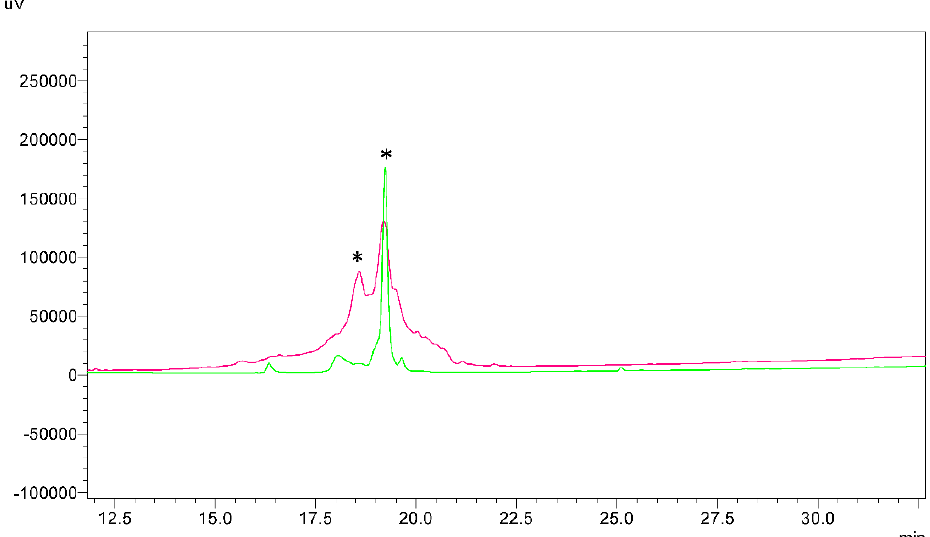
Figure 7. Chromatograms of the folded HBD-3. A green trace denotes the native-like form of HBD-3 #1 synthesized using the orthogonal Cys protection strategy. A pink trace indicates products of the directly folded HBD-3 carried in the presence of 1 mM GSSH and 1 mM GSH, 0.1 M Tris-HCl (pH 7.5). The two main peaks of the directly folded HBD-3, with the same mass as expected for the native HBD-3, are marked with asterisks. The second peak (HBD-3 #2), with related time to the native-like form of HBD-3 #1 was collected and its antimicrobial activity was tested as well as HBD-3 #1.